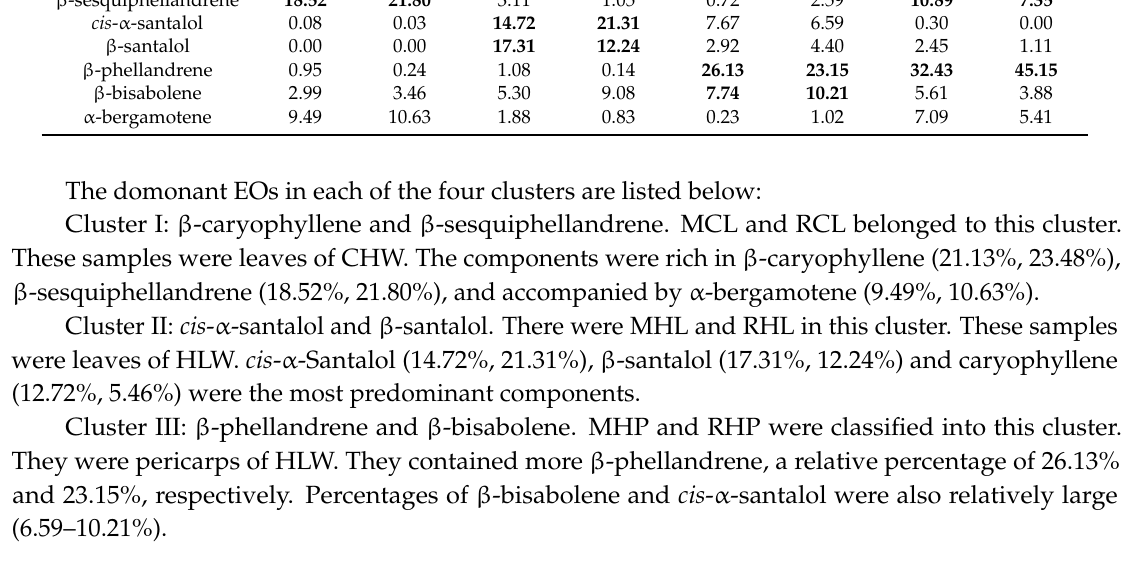
Table 3. Variation of some important volatile components (%) of Clausena lansium in four clusters. Cluster I Cluster II Cluster III Cluster IV Components MCL RCL MHL β